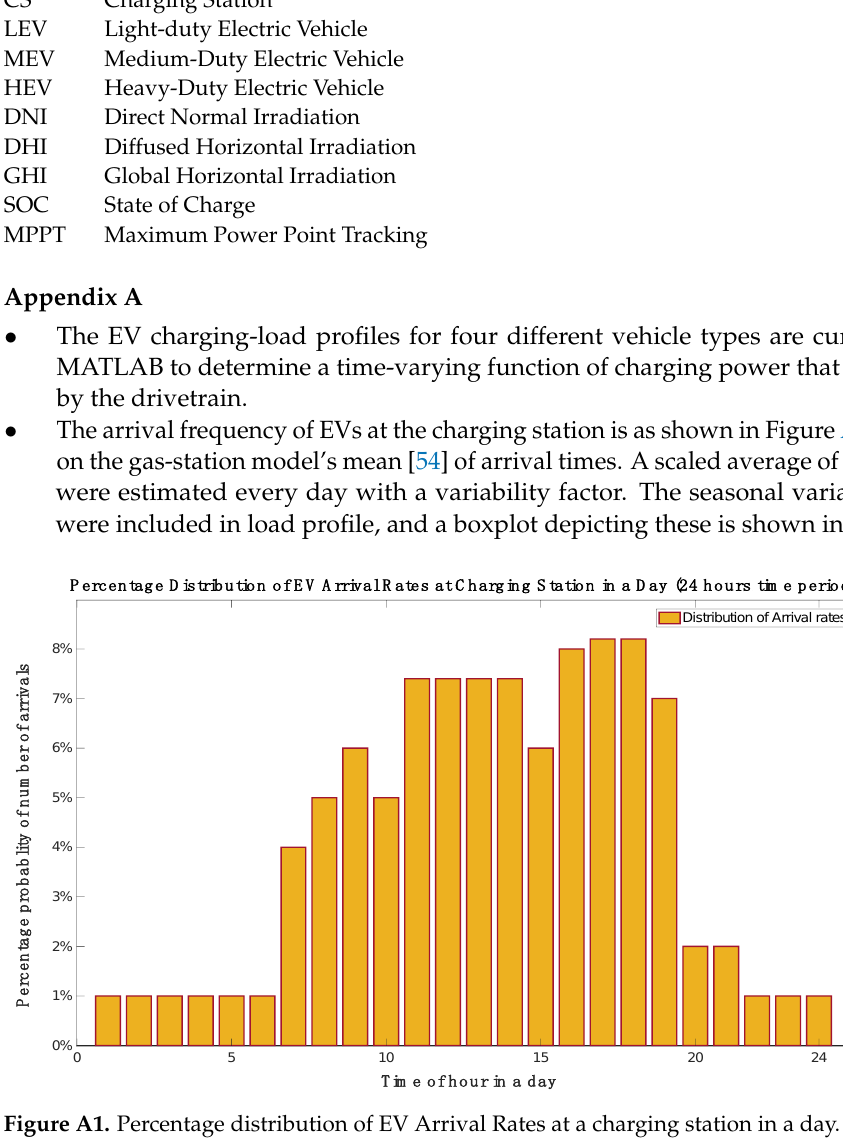
Figure A1. Percentage distribution of EV Arrival Rates at a charging station in a day.